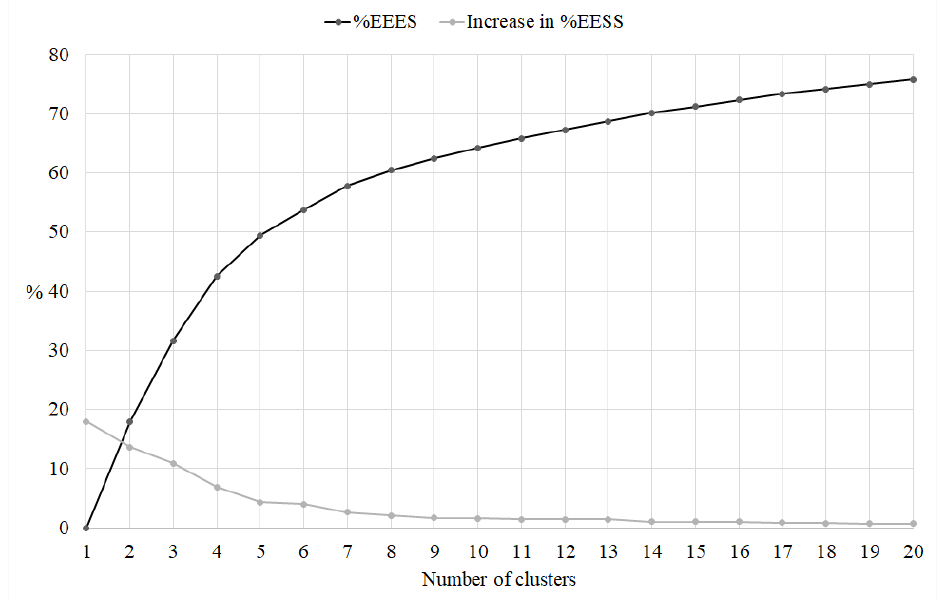
Figure 1. Scree-type plot for the cluster solutions. %EESS = explained error sum of squares percentage. Increase in %EESS = size of the change in the %EESS of adjacent solutions. The x -axis reports the number of clusters of each solution; the y -axis reports the percentages.